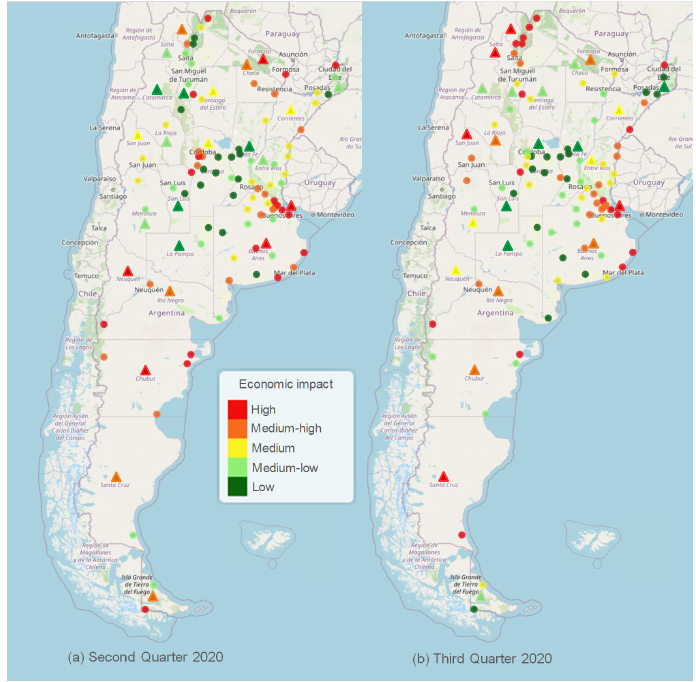
Figure 5: Quarterly maps of economic impact: quintiles for provinces and